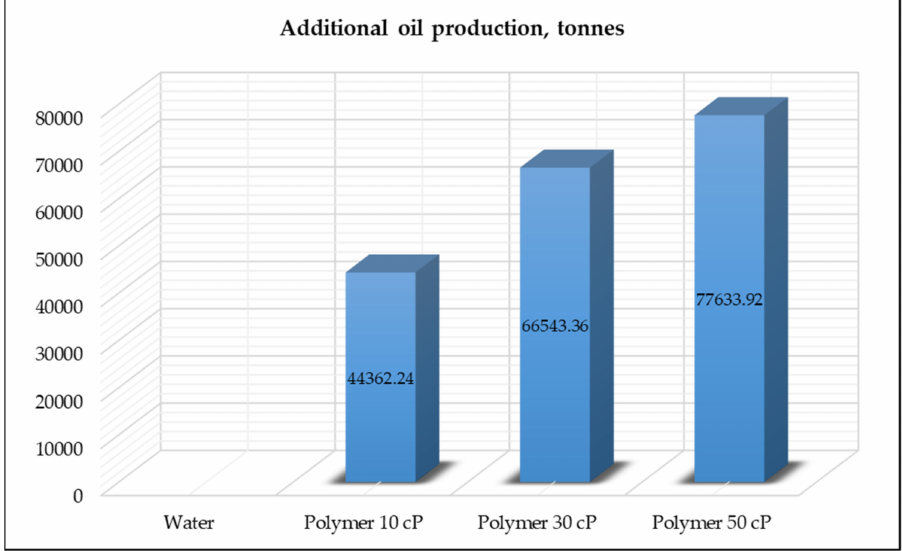
Figure 10. Additional oil production by different options for oil